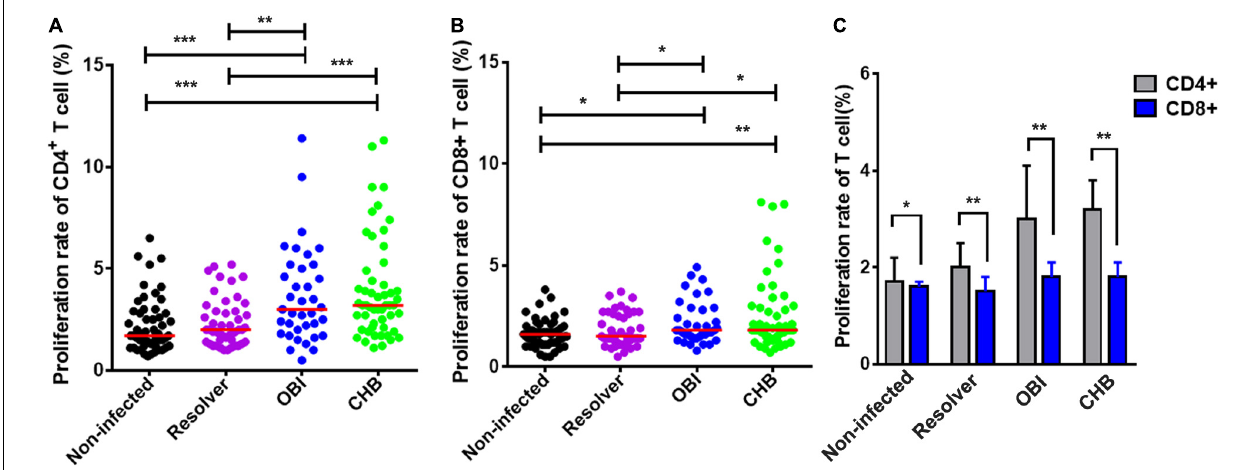
FIGURE 1 | Proliferation rates of CD4 + and CD8 + T cells from blood donors with different outcomes of HBV infection stimulated with HBV core peptides. (A,B) HBV-core specific CD4 + or CD8 + T-cell proliferation rate. Each group median is indicated, and each dot represents a rate for T cell proliferation from four groups of individual blood donors. (C) Comparison of the median frequencies between CD4 + and CD8 + T cell proliferation rates in each study group. P -values are analyzed by one-way ANOVA and two-tailed t -test. Statistically significant differences are shown with asterisks (* P < 0.05, ** P < 0.01, and *** P < 0.001).